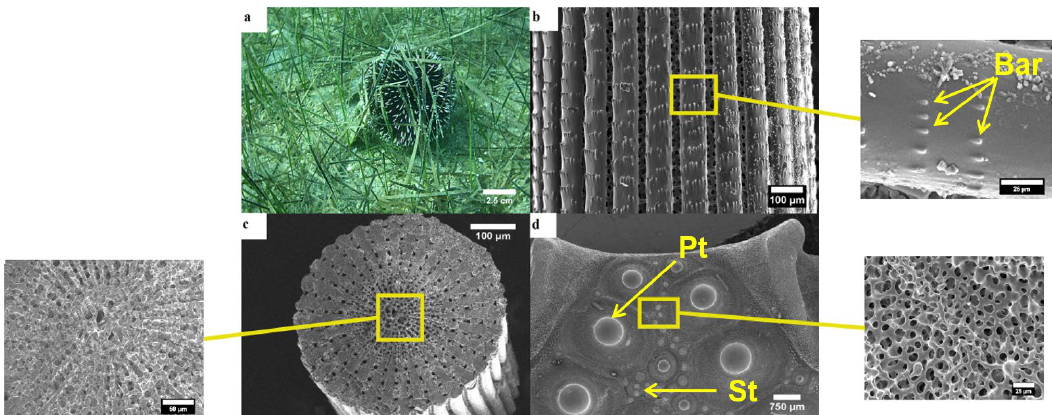
Figure 5. The purple sea urchin Sphaerechinus granularis . ( a ) General in situ view of the aboral side; ( b ) longitudinal section of the shaft of the spine (×100), with enlarged image showing rows of barbs on a wedge (×1100); ( c ) transverse section of the spine (×140), with enlarged image showing the porous zone (×400); ( d ) section of the test from the peristomal region (×16), with enlarged image showing the stereom of the outer surface. Bar—barbs, Pt—primary tubercles, St—secondary tubercles.